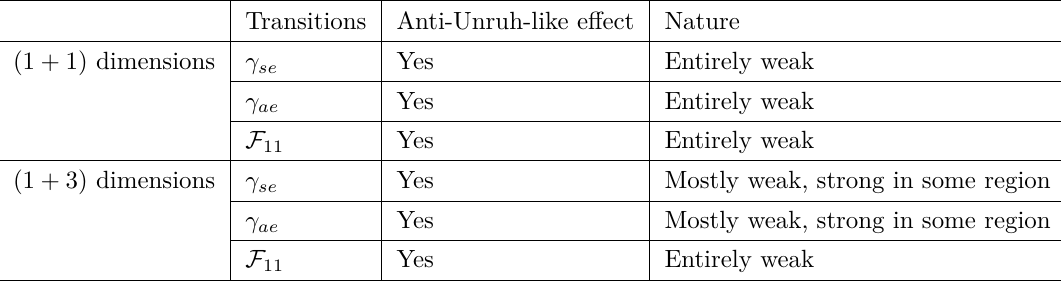
Table 1 . The case with the Minkowski modes.